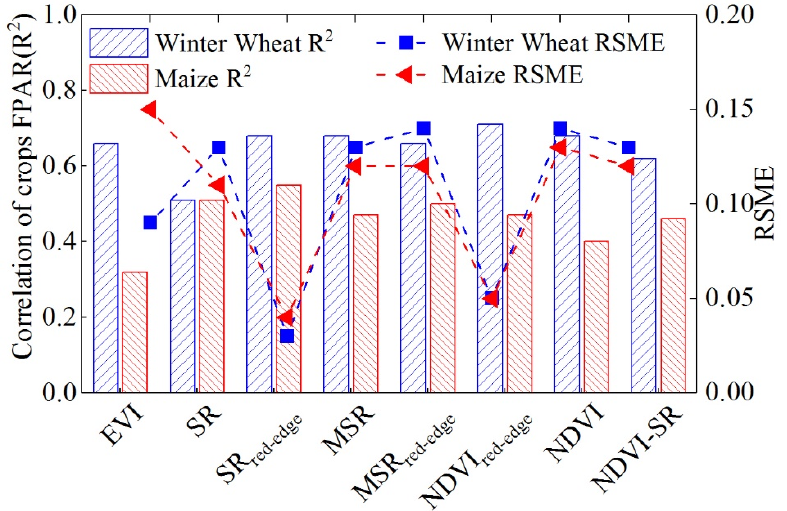
Figure 14. Correlation histogram of the predicted FPAR of winter wheat and maize in the main growing seasons.